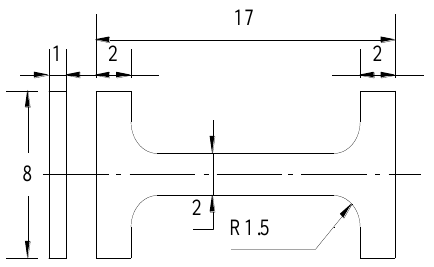
Figure 4. Wire-cut tensile specimens (in mm) from the center of the bar specimens along the transversal